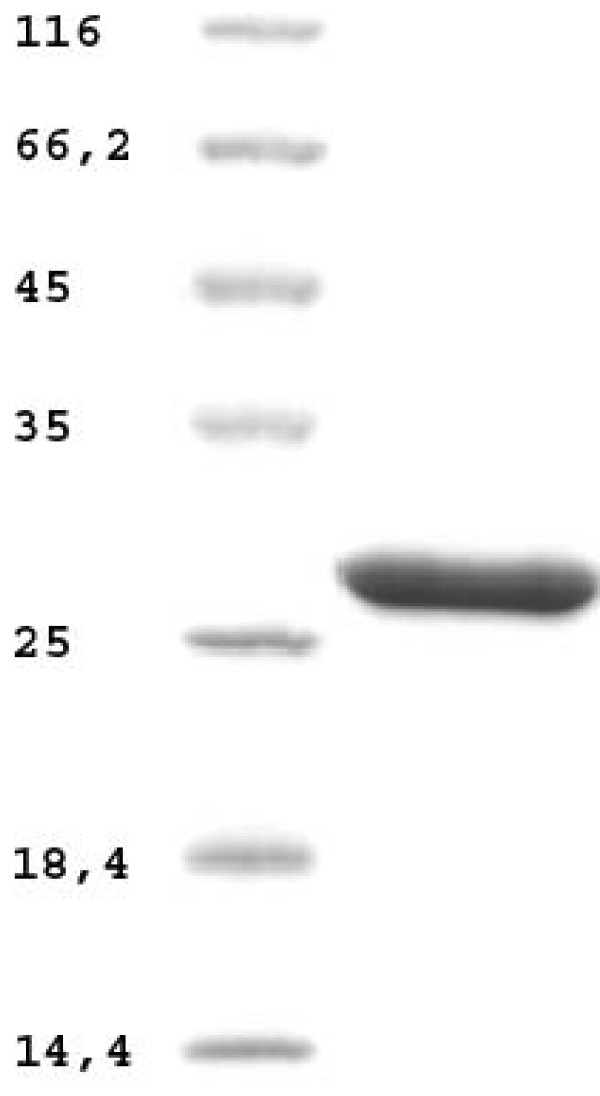
SDS-PAGE analysis of the purified YfhQ protein. Left lane, molecular mass markers (Pharmacia-Biotech). Right lane, purified recombinant YfhQ.